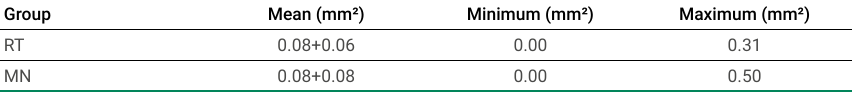
Table 2. Mean (±SD), minimum and maximum area (mm²) of remaining filling material in the sections according to the experimental groups Group